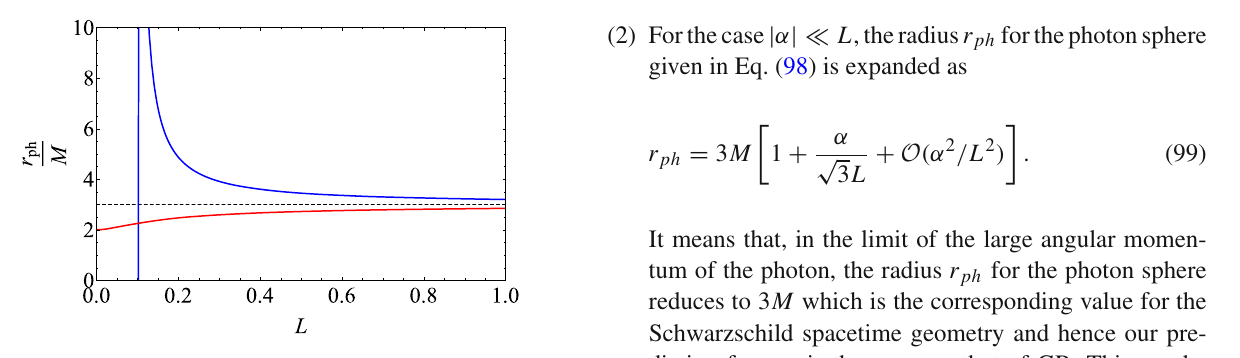
Fig. 3 The scaled radius r ph / M for the photon sphere as a function of the angular momentum L at | α | = 1 / 10. The blue and red curves correspond to r + ( α = 1 / 10) and r − ( α = − 1 / 10), respectively. The ph ph horizontal dashed black line refers to the prediction of GR, r ph = 3